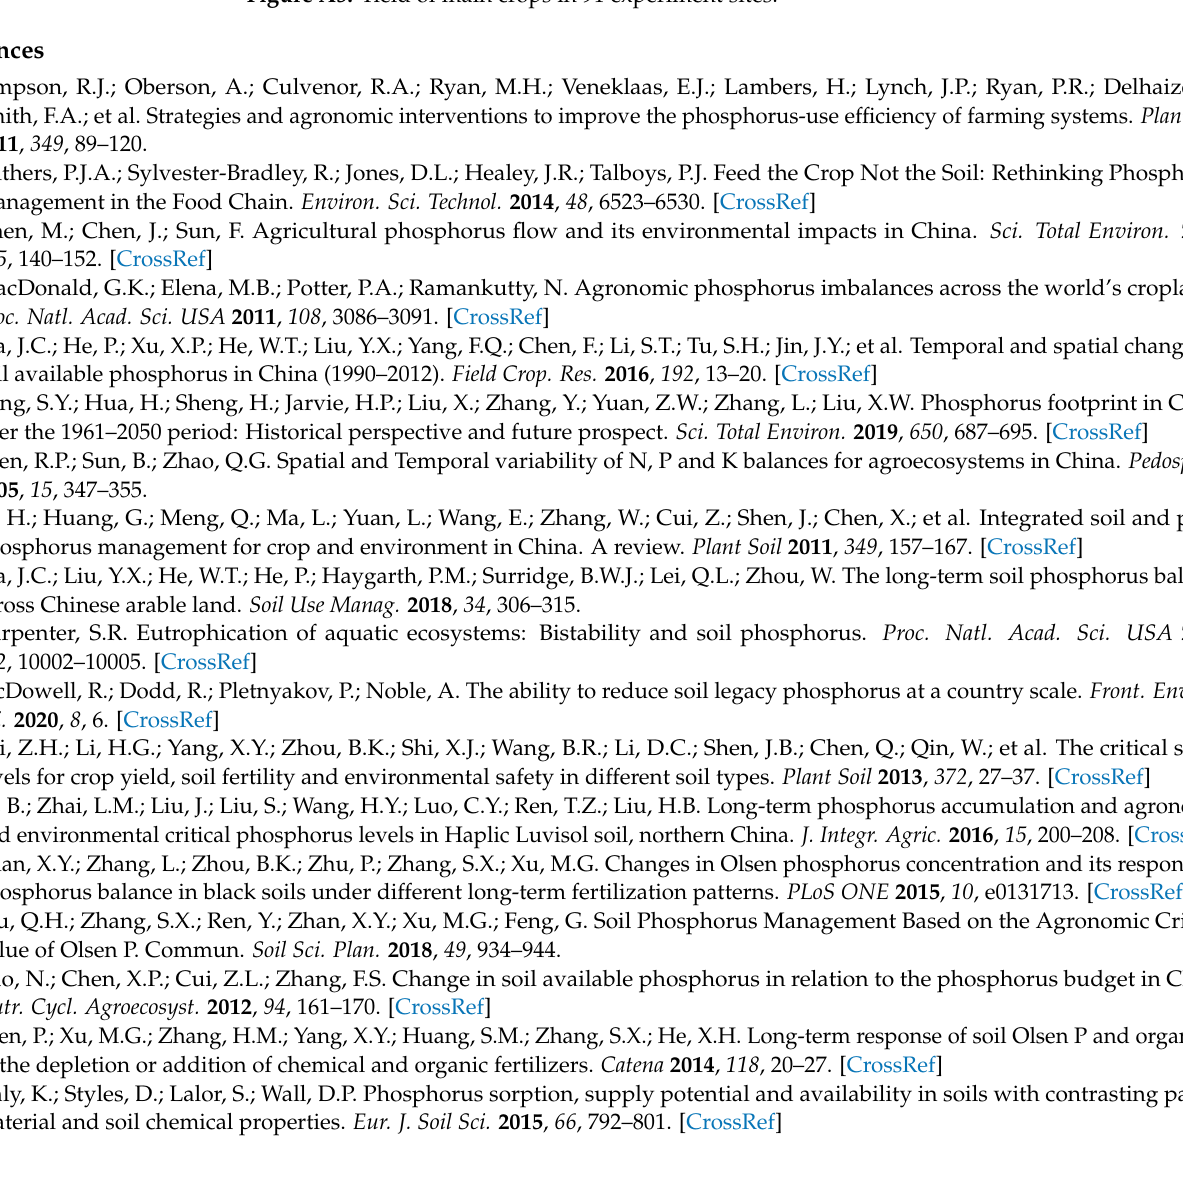
Figure A5. Yield of main crops in 91 experiment sites.